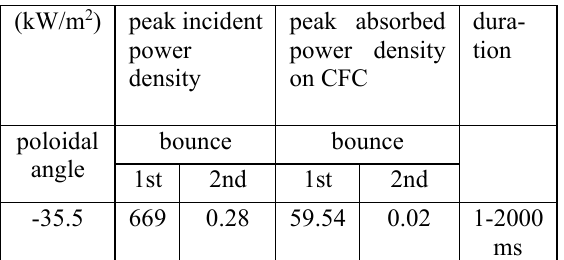
Table 4. Low absorption phase scenario 2, 138 GHz at